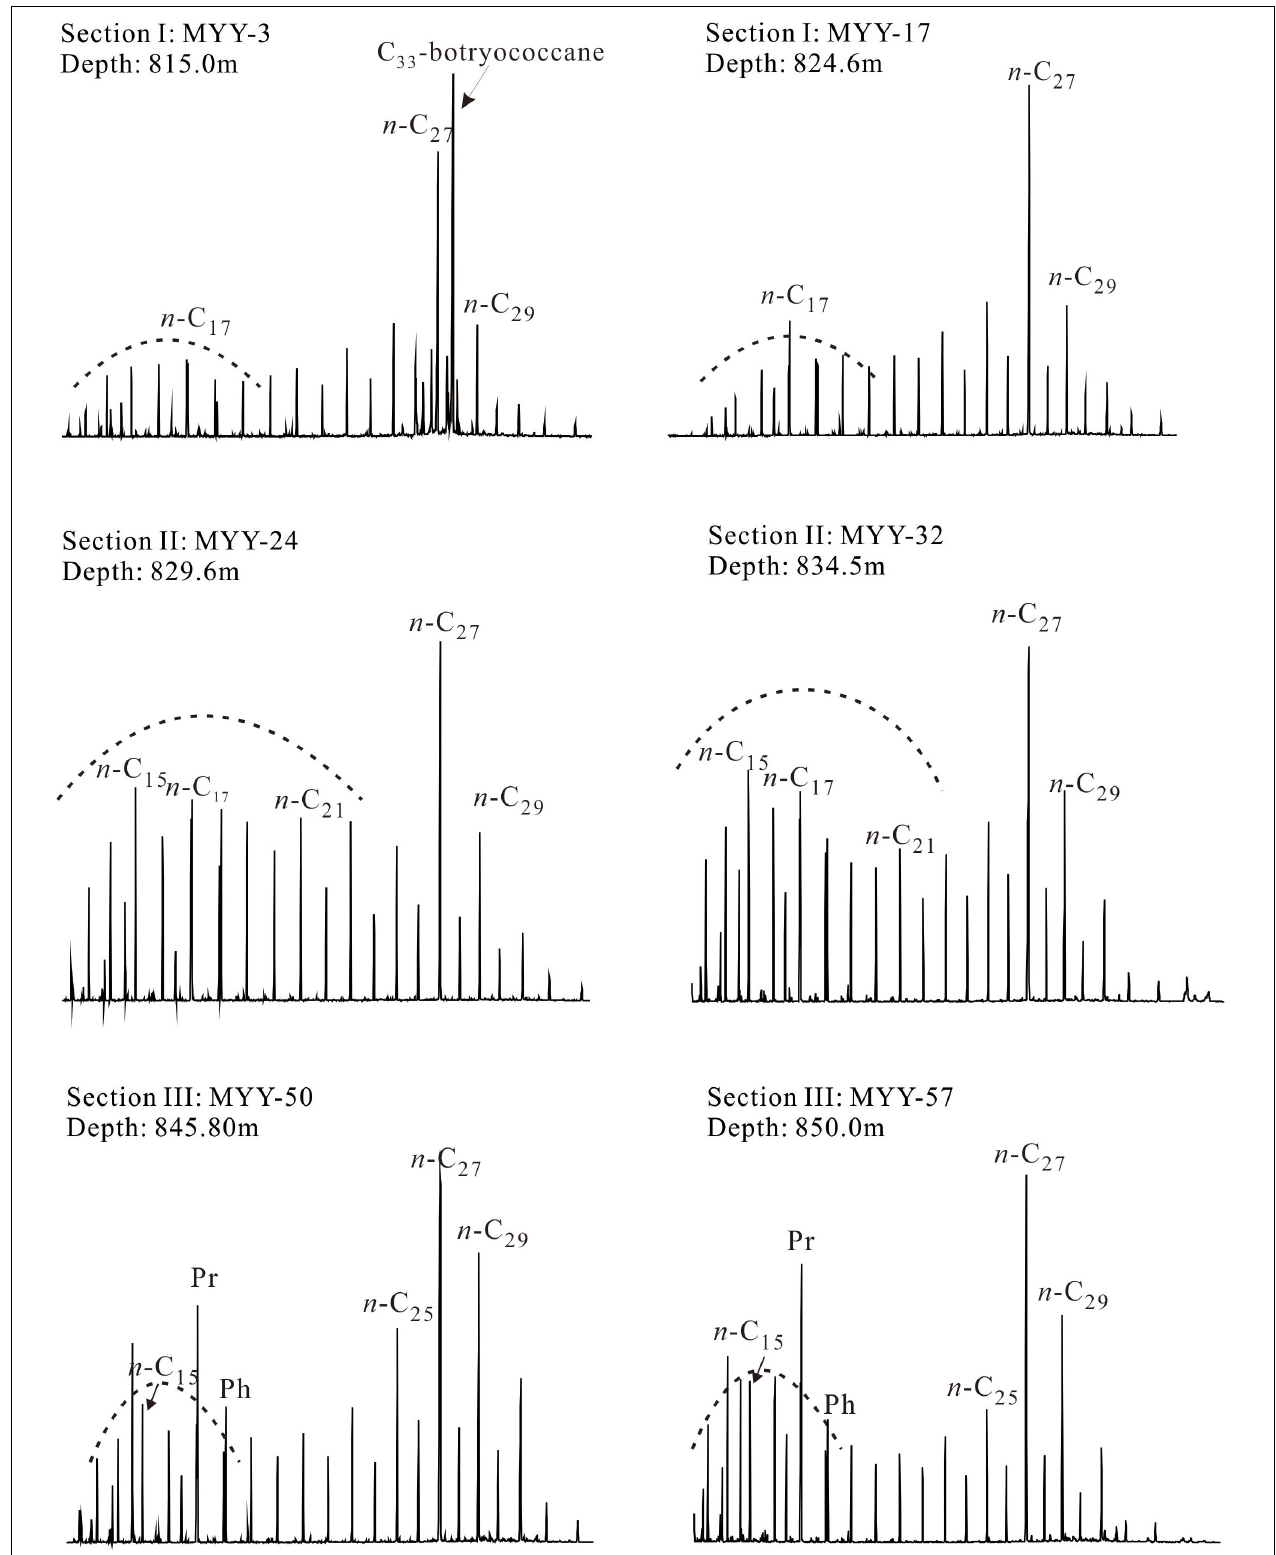
FIGURE 3 | Chromatograms of aliphatic alkane compounds in representative oil shale samples (Pr = pristine; Ph = phytane).